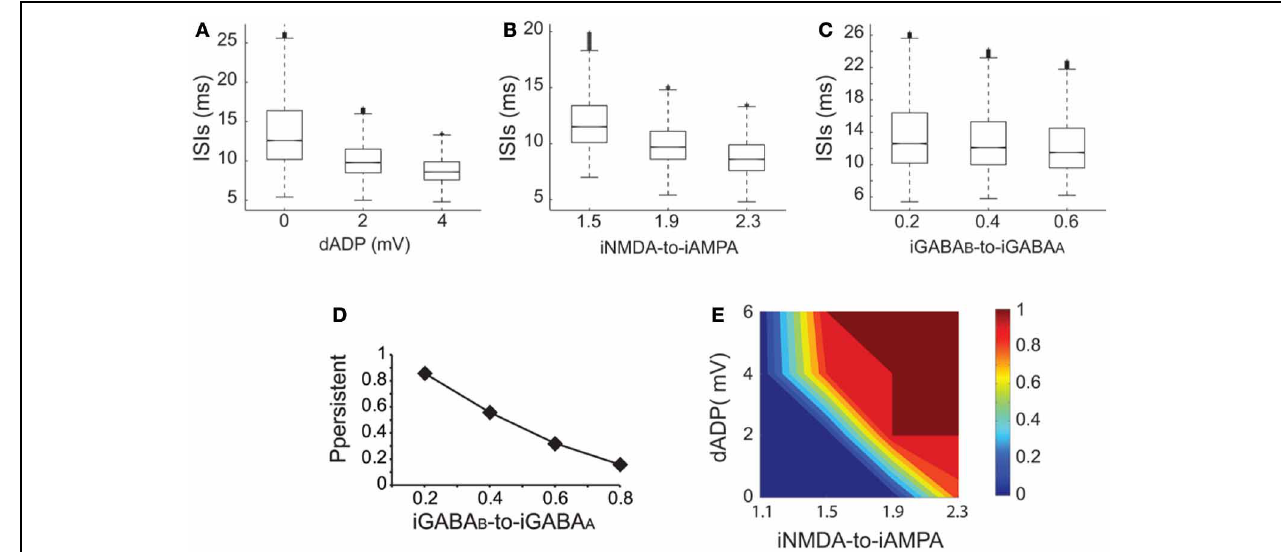
sustained activity emergence in the microcircuit as a function of the iGABA B -to-iGABA A ratio (iNMDA-to-iAMPA = 2.3, dADP = 0mV). (E) 2-D contour plot showing the combined effects of the dADP mechanism (0–6mV) and the iNMDA-to-iAMPA ratio (1.1–2.3) on the probability of persistent activity induction. Blue: failure of induction, red: induction in 100% of the trials (iGABA B -to-iGABA A ratio =